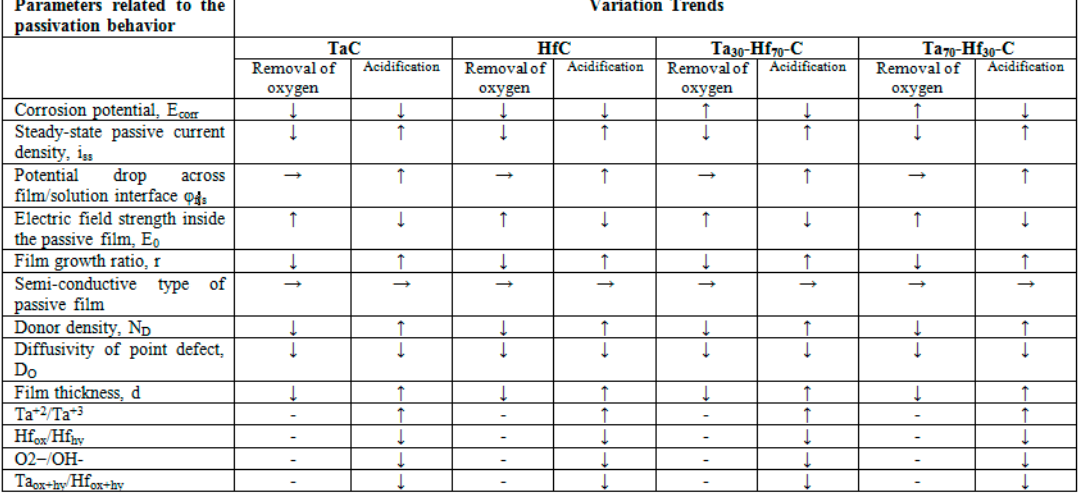
Figure 18. Summary of solution chemistry effects on the passivation characteristics of Ta X - Hf X-1 C.